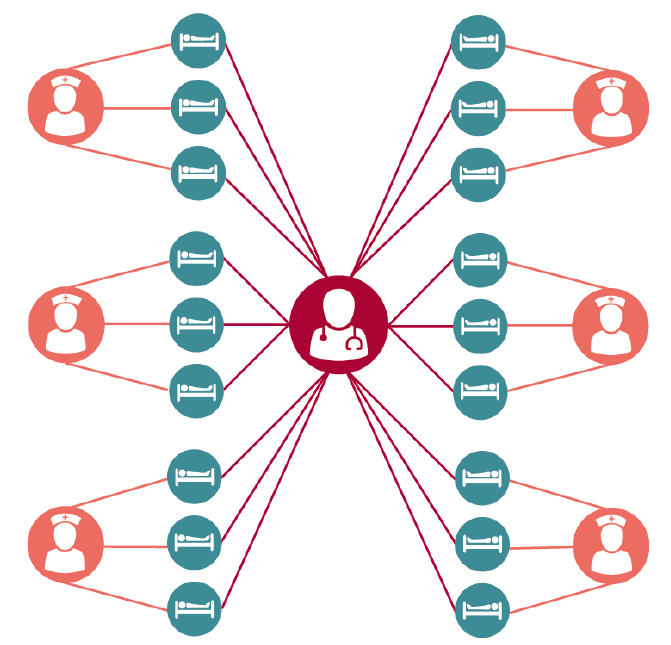
Figure 2. Structured layout of an intensive care unit. Patients (teal) are treated by a single assigned nurse (orange), while a single intensivist (red) randomly treats all patients in the ward. Figure by Eric Lofgren is licensed under CC-BY-4.0.